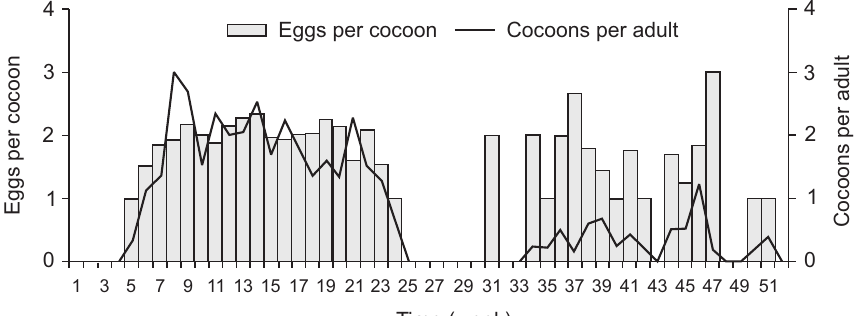
Figure 3. Number of cocoons per adult and average of eggs per weekly cocoons of B. sowerbyi cultivated in medium sand (0.250-1.000 mm) at 25 ±